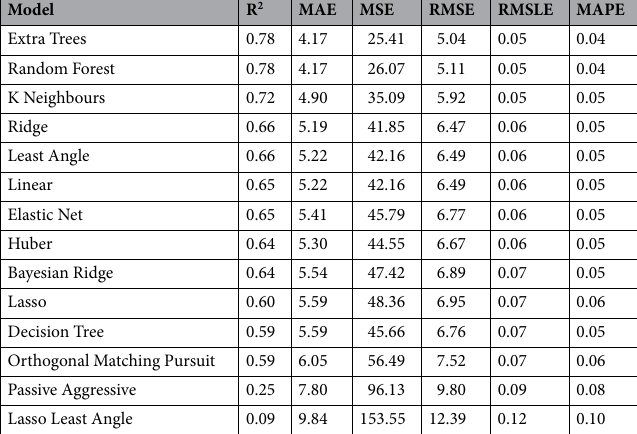
Table 6. Summary of comparison between various ML